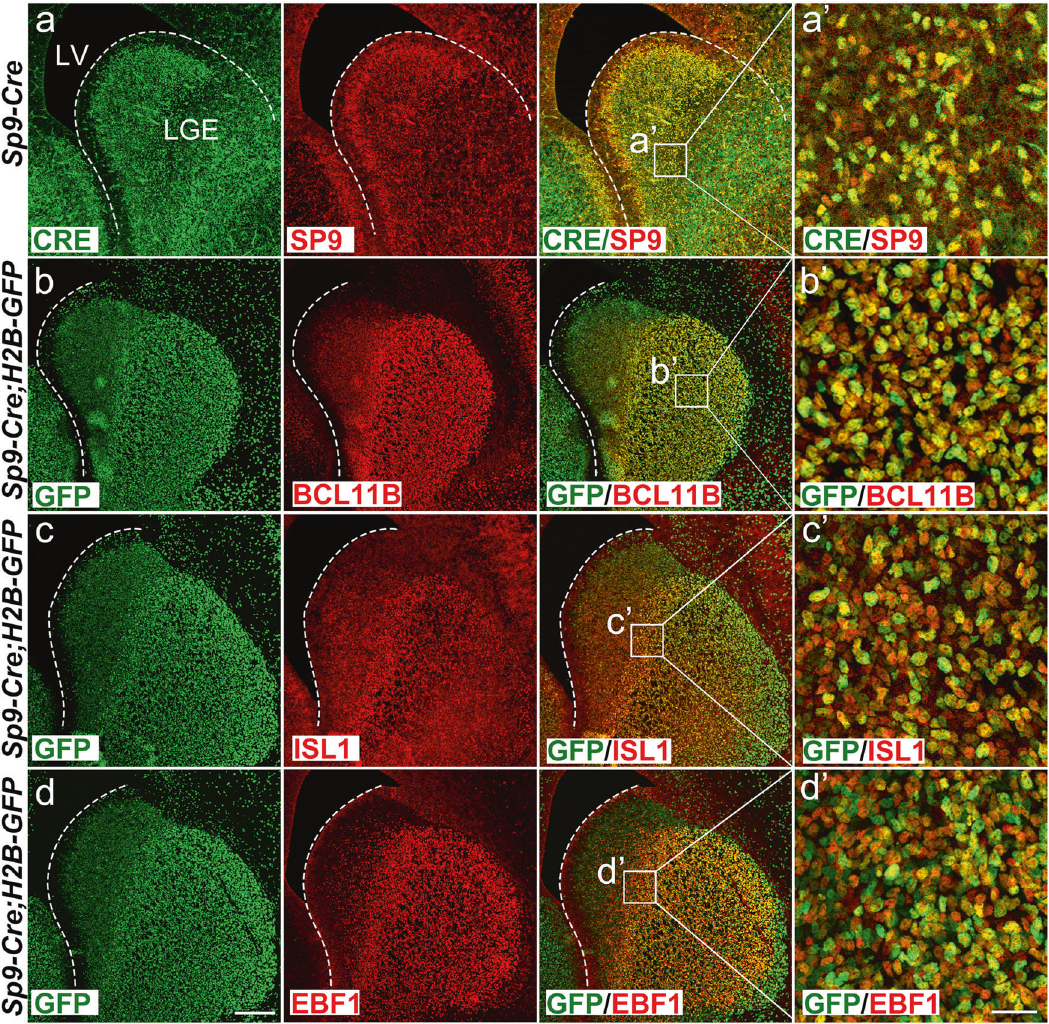
Fig. 3 SP9 + LGE progenitors generate both D1-MSNs and D2-MSNs. a CRE/SP9 double immunostaining in the LGE of the Sp9-Cre mice at E16.5. a ’ Higher magni fi cation images of CRE + /SP9 + cells in the LGE. b BCL11B/GFP double immunostaining in the Sp9-Cre; H2B-GFP LGE at E16.5. b ’ Higher magni fi cation images of BCL11B + /GFP + cells in the LGE. c ISL1 + /GFP + double immunostaining in Sp9-Cre; H2B-GFP LGE at E16.5. c ’ Higher magni fi cation images of ISL1 + /GFP + cells in the LGE. d EBF1 + /GFP + double immunostaining in Sp9-Cre; H2B-GFP LGE at E16.5. d ’ Higher magni fi cation images of EBF1 + /GFP + cells in the LGE. Scale bars: 100 µm in d for a – d , and 25 µm in d ’ for a ’ – d ’